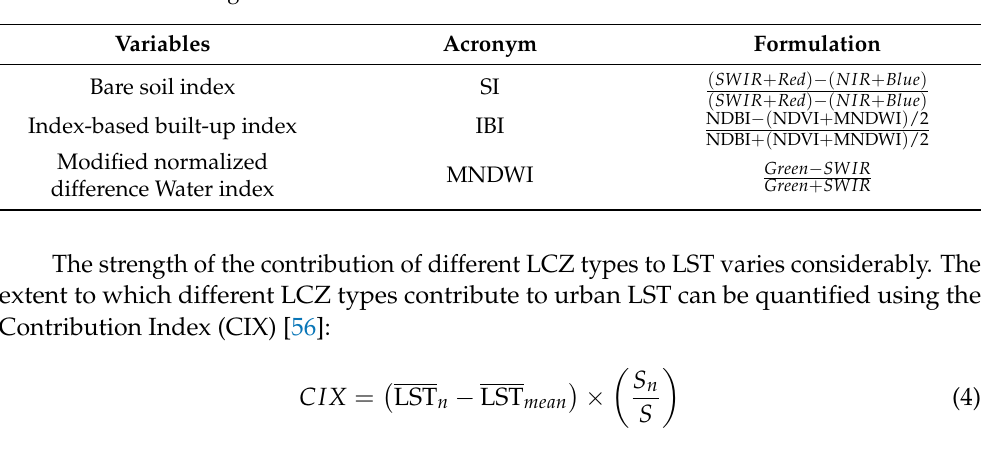
Table 3. Remote sensing index